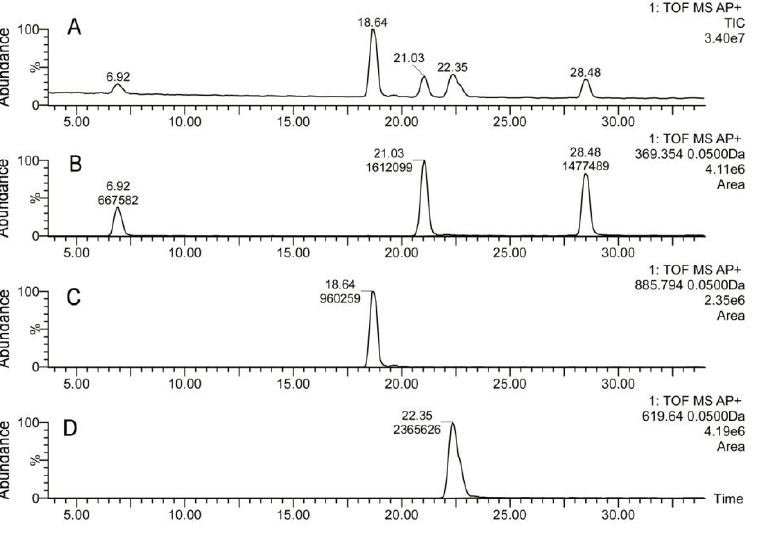
Figure 4. RP UPLC/APCI MS analysis of a series of equimolar lipid standards. ( A ) Total ion chromatogram of a 50- µ M (each compound) mixture of free cholesterol (retention time 6.92 min), cholesteryl oleate (21.03 min), cholesteryl nervonate (28.48 min), triolein (18.64 min), and lignoceryl oleate (22.35 min). Panels ( B ), ( C ), and ( D )—extracted ion chromatograms of the standards, whose m/z values are indicated in the right corners of the panels, while the peak retention times and areas—near the top of each peak.